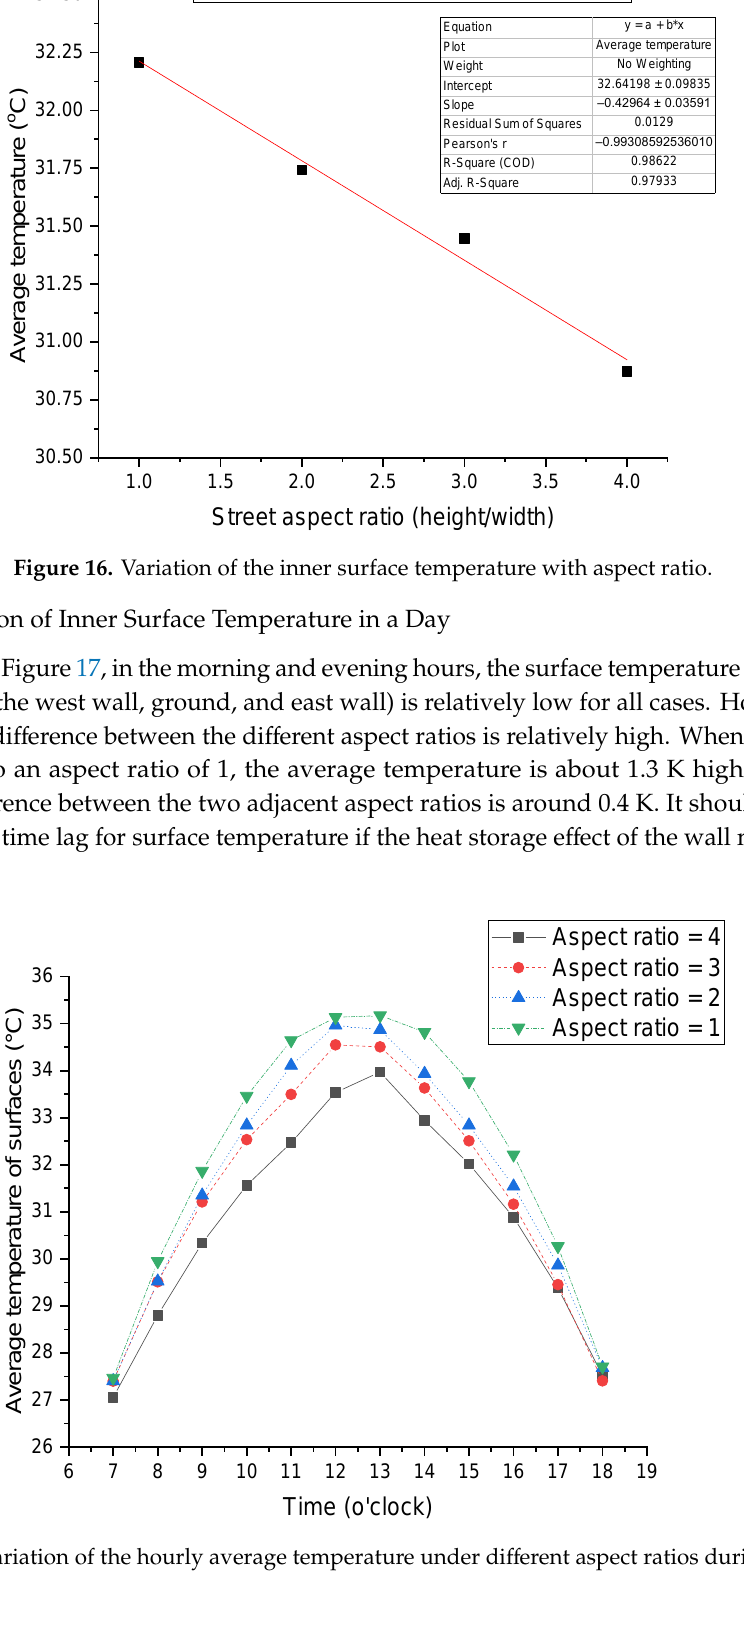
Time (o' clock) Field measured CFD simulation converted by similarity Figure 15. Hourly temperature by measurement and CFD simulation in the street canyon. It can be seen from Figures 14 and 15 that the spatial distribution of the temperature simulated and transformed by CFD is more accurate with a similar trend to the measured data. However, it has a time lag and an error of 30%. Therefore, in the following analysis, only the average temperature distribution on the surface of the block is analyzed, and the variations of temperatures over time are not considered. 5.2. Results Analysis 5.2.1. The Average Temperature in the Street Canyon with Different Aspect Ratios